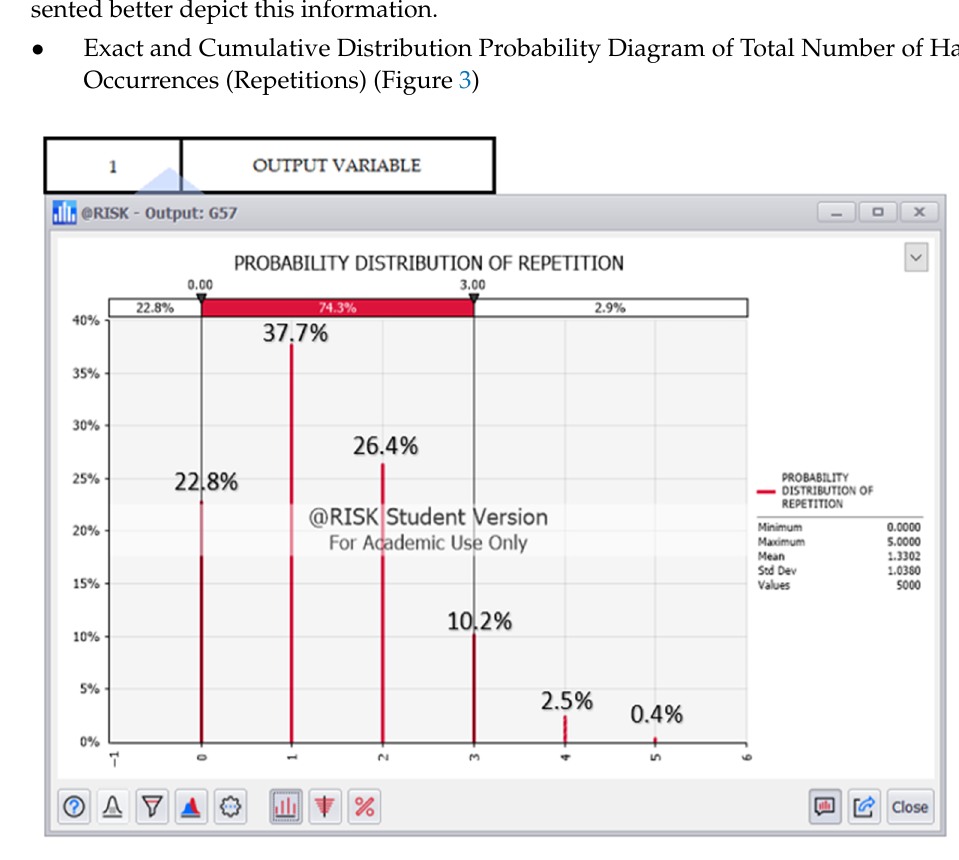
Figure 3. Risk—risk recurrence probability distribution